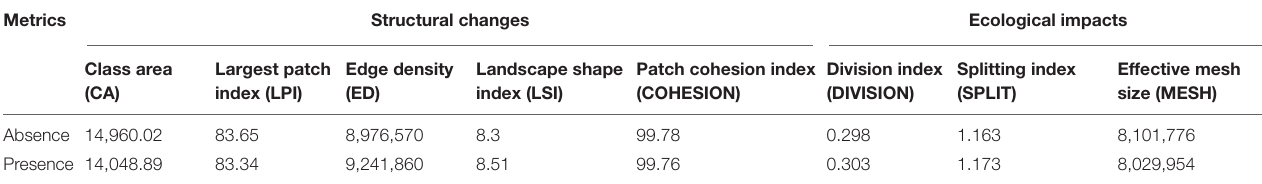
TABLE 3 | Assessing habitat degradation and fragmentation of the Tang-e Bostanak Protected Area before and after construction of the Isfahan-Shiraz highway. Metrics Structural changes Ecological impacts Class area Largest patch Edge density Landscape shape Patch cohesion index Division index Splitting index Effective mesh (CA) index (LPI) (ED) index (LSI) (COHESION) (DIVISION) (SPLIT) size (MESH) Absence